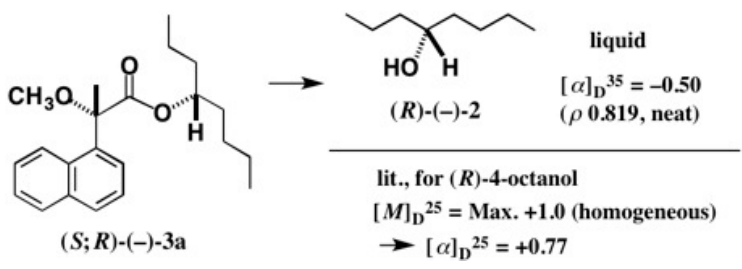
Figure 4. Recovery of enantiopure 4-octanol ( R )-( − )- 2 and its optical rotation data. The literature data: [ M ]D25 value from [20]; [ α ]D25 value estimated from [ M ]D25 by us.